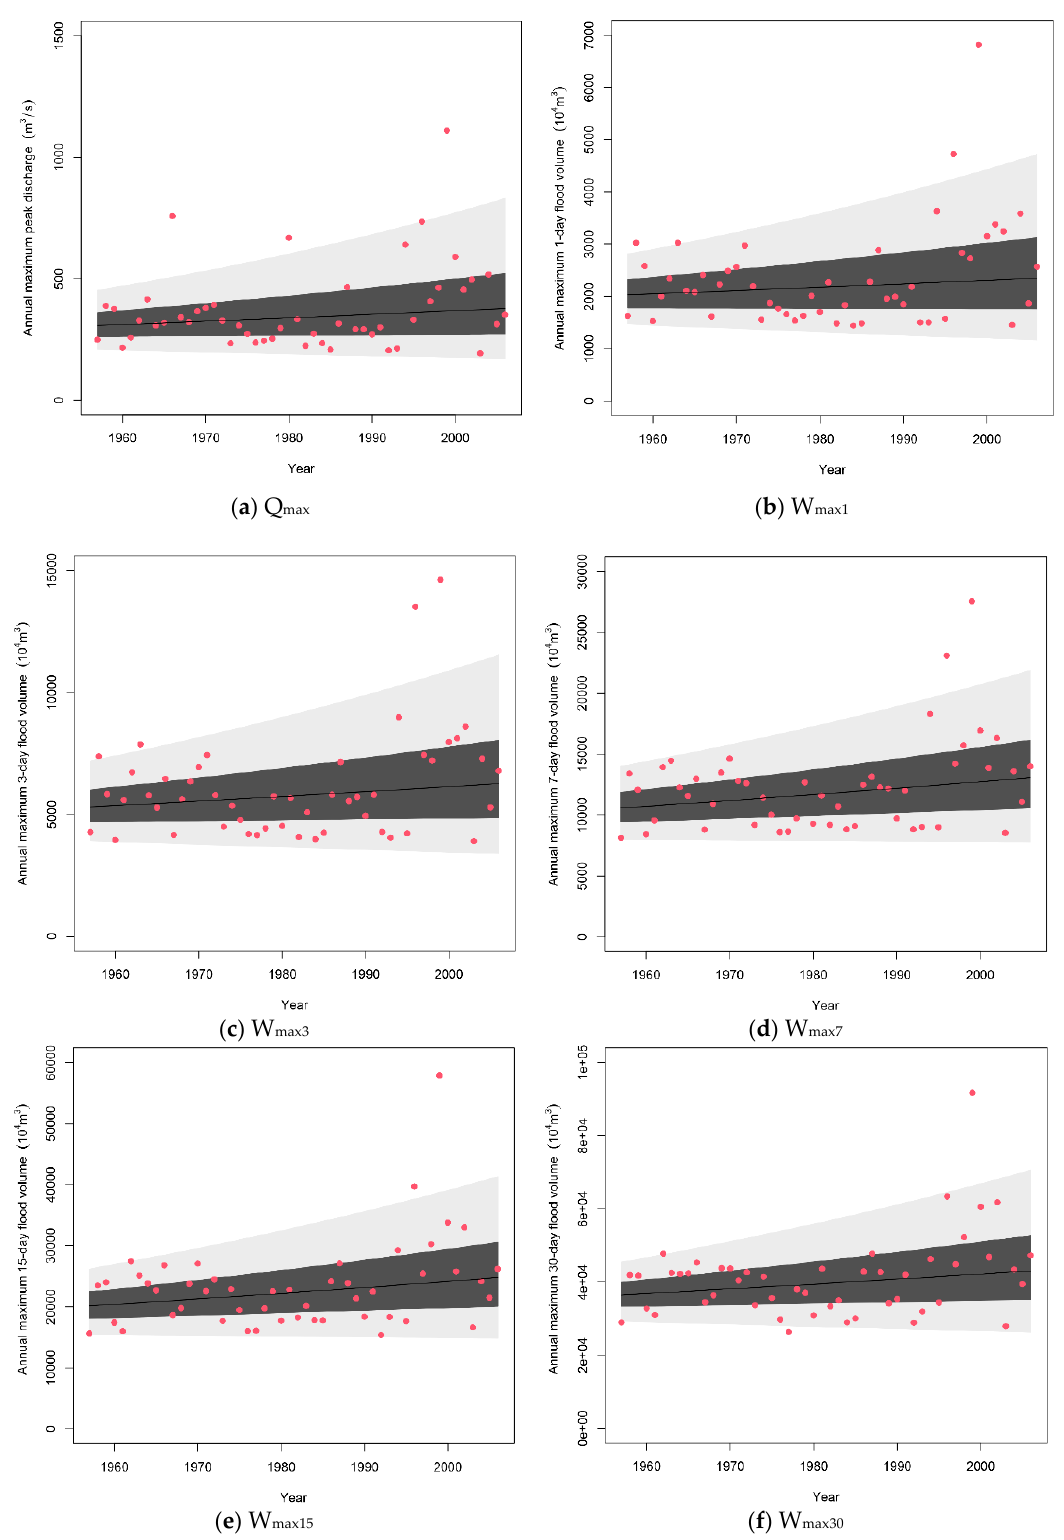
Figure 5. The series of snowmelt flood is modeled using Log Normal distribution, with parameters depending on time t (Model 1).The red points indicate the actual measured points of the snowmelt flood feature series; the light gray region represents the area between 5th and 25th quantile percentile; the dark gray region in the middle represents the area between 25th and 75th percentile; the upper light gray region represents the area between the 75th and 95th percentile; the middle black curve represents the median (50th percentile).